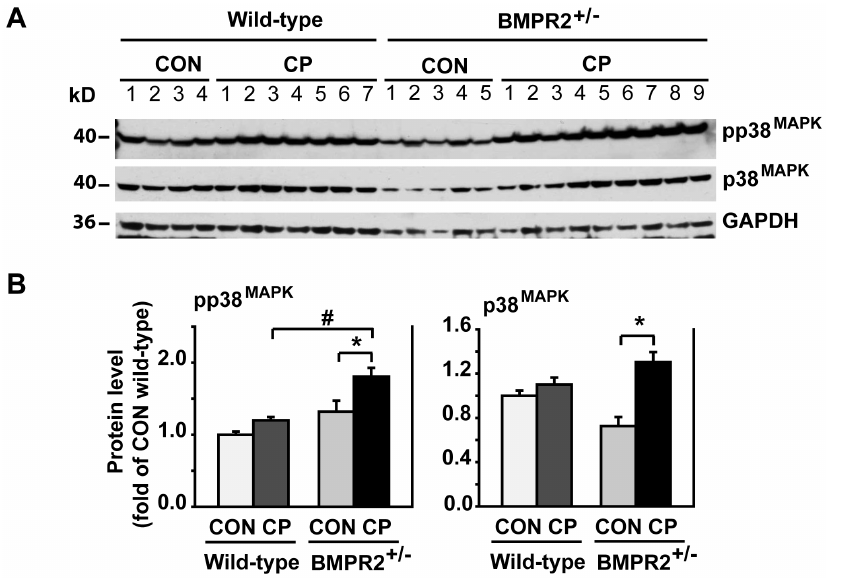
Figure 5. pp38 MAPK signaling increased in BMPR2 + / 2 mice after CP induction. (A) Western blotting of pancreatic tissue lysates from wild- type and BMPR2 + / 2 mice with anti-pp38 MAPK and total p38 MAPK antibodies. (B) Quantification of the Western blots. The protein levels were normalized against GAPDH and quantified as fold of CON wild-type. CON wild-type: n=4, CON BMPR2 + / 2 : n=5, CP wild-type: n=7, CP BMPR2 + / 2 : n=9. * P , 0.05 compared with CON, # P , 0.05 compared with CP wild-type.